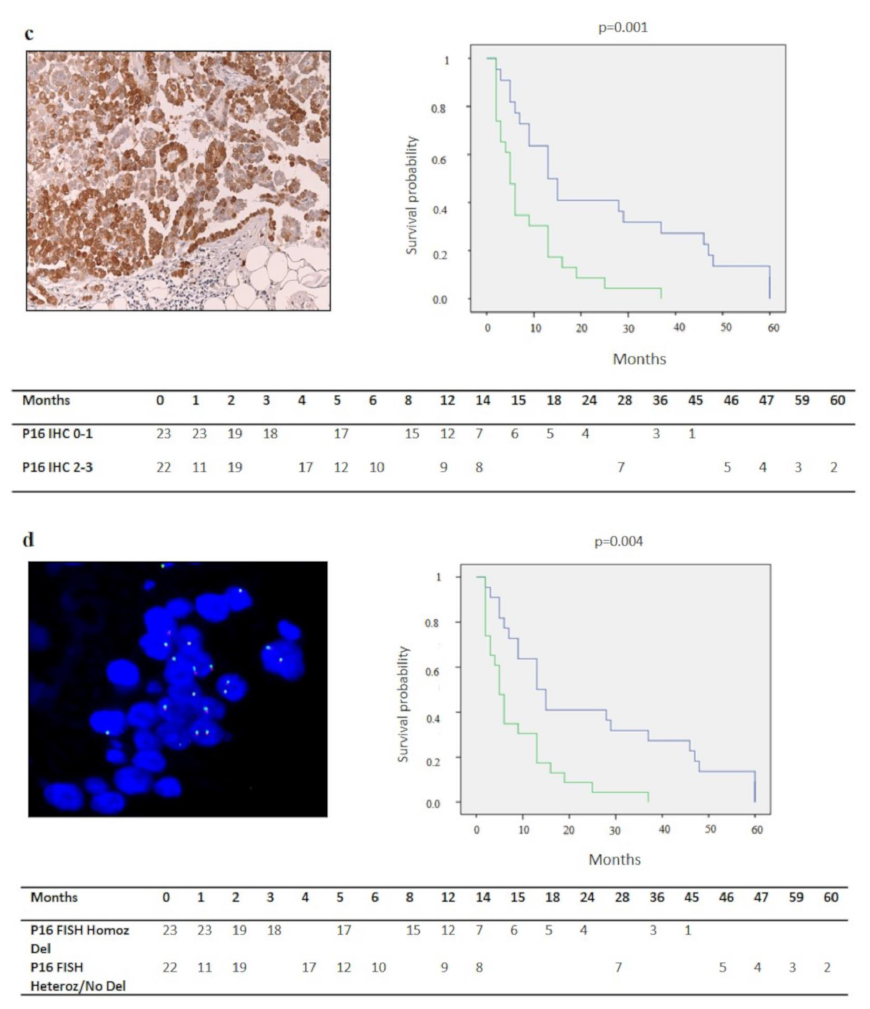
Figure 2. Correlation between immunohistochemical and molecular variables and survival. Ki67 >25% (immunohistochemistry, original magnification ×400). ( a ) and WT-1 ≤ 15% (immunohistochemistry, original magnification ×400); ( b ) showed a shorter survival, whereas high p16 immunostaining score (immunohistochemistry, original magnification ×100); ( c ) and/or absence or heterozygous CDKN2A deletion showed a longer survival when compared with their counterparts; ( d ) (Green lines for: Ki67 >25% in a , WT-1 >25% in b , score 0 – 1 of p16 in c , homozygous deletion of CDKN2A in d . Blue lines for: Ki67 ≤ 25% in a , WT-1 ≤ 25% in b , score 2 – 3 of p16 in c , no/heterozygous deletion of CDKN2A in d ).